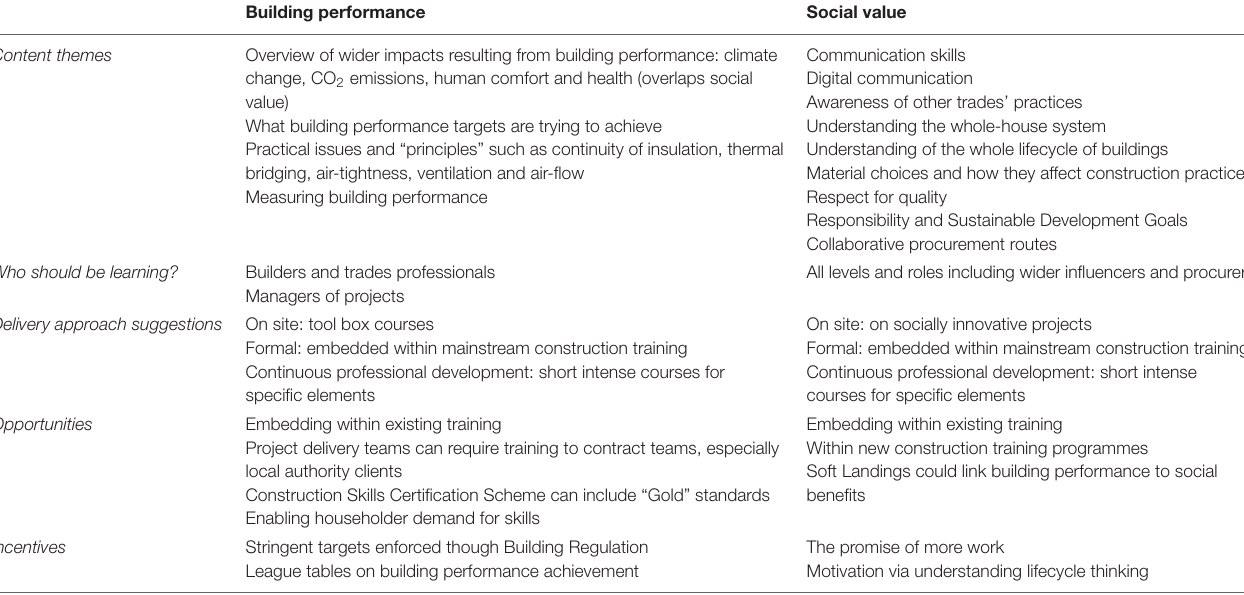
TABLE 1 | Summary of insights for “Building Performance” and “Social